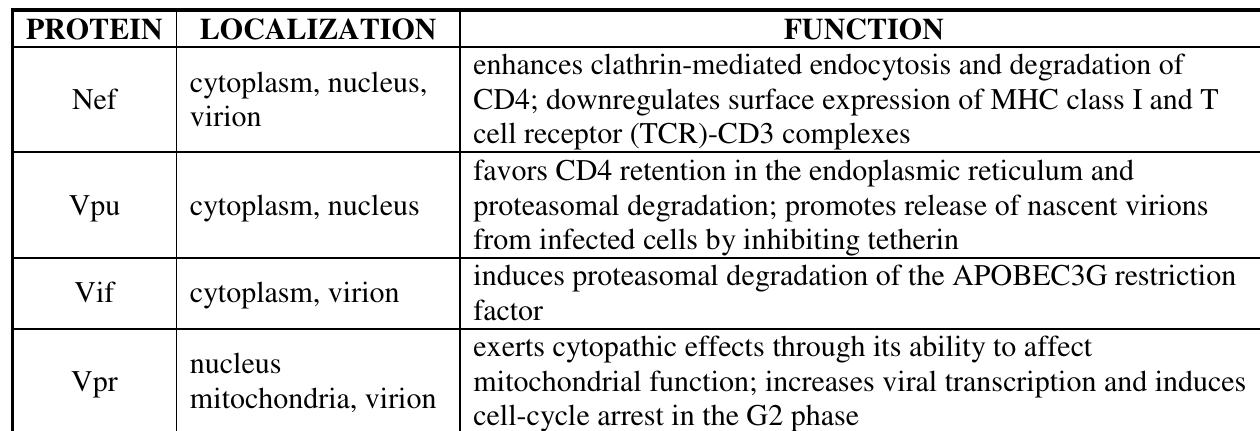
Figure 1. Exon composition and coding potential of the main plus-strand mRNAs of HIV-1 (reviewed in [16]) ( A ) and HTLV-1 ( B ). The INhibitory Sequences (INS) and the Rev/Rex-Responsive Element (RRE/RXRE) are indicated by red hexagons and green boxes, respectively.